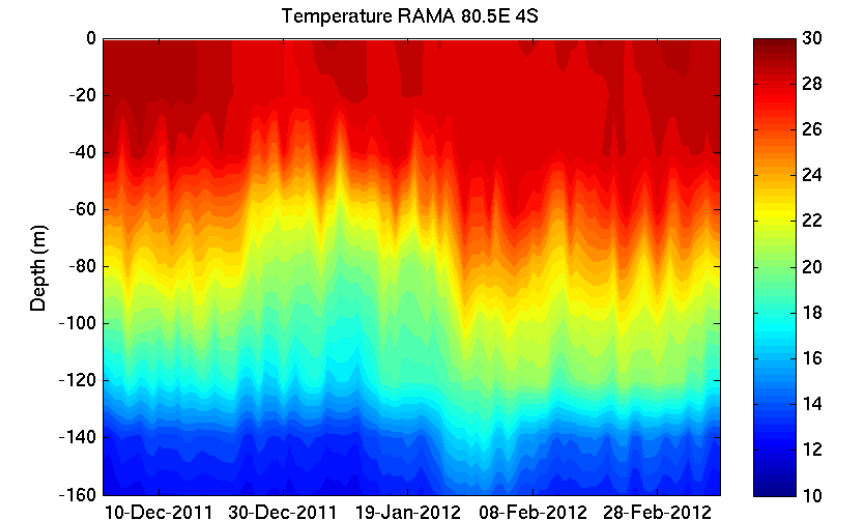
Figure 10. Time series of temperature (°C) profile from the RAMA buoy at 4°S,